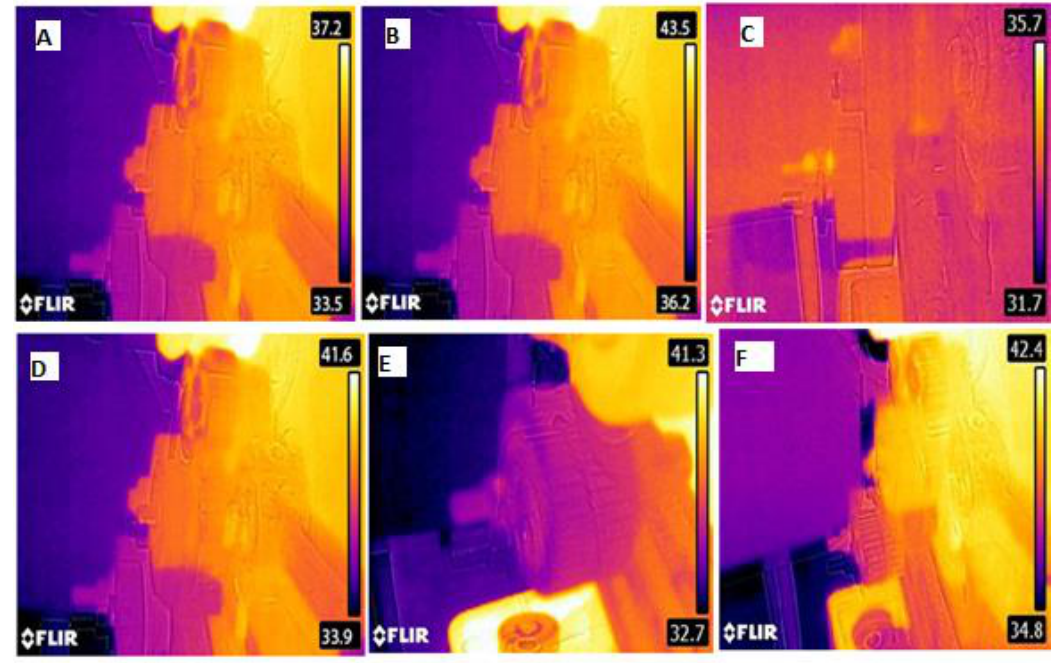
Figure 10. Thermal images. ( A ) Initial temperature of GFRPG-15. ( B ) Final temperature of GFRPG-15. ( C ) Initial temperature of FFRPG-15. ( D ) Final temperature of FFRPG-15. ( E ) Initial temperature of SFRPG-15. ( F ) Final temperature of SFRPG-15. Fibers 2018 , 6 , x FOR PEER REVIEW